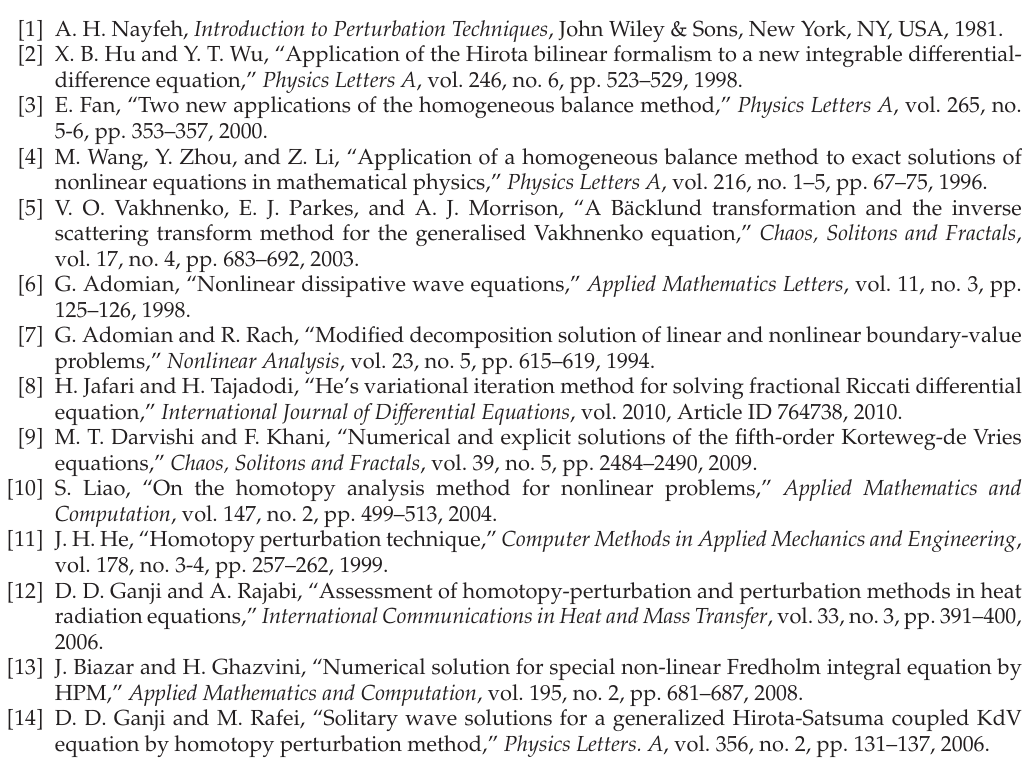
Table 3: Comparison between absolute errors of ADM, VIM, and HPM for t (cid:9) 0 . 1, c (cid:9) 3. x A A (cid:6) 49 (cid:7) A exact - ADM − 10 1 . 42109 E −